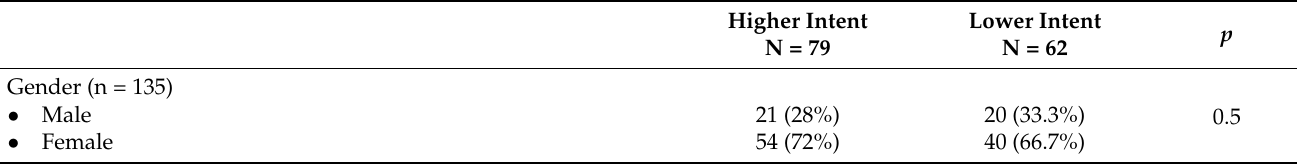
Factors Associated with Participants’ Intention to Serve the Underserved and Vulnerable